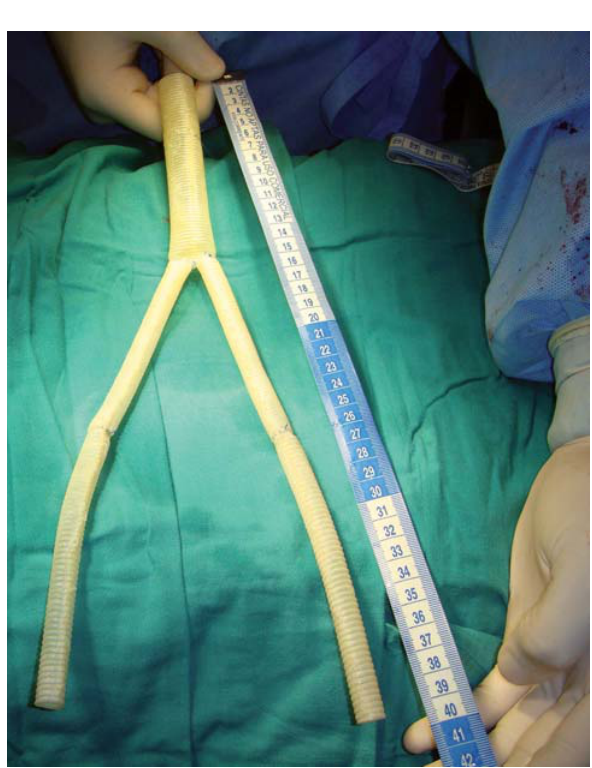
Fig. 3 - Complete constructed bifurcated 21 by 11 by 300 mm corrugated bovine pericardial tubular graft